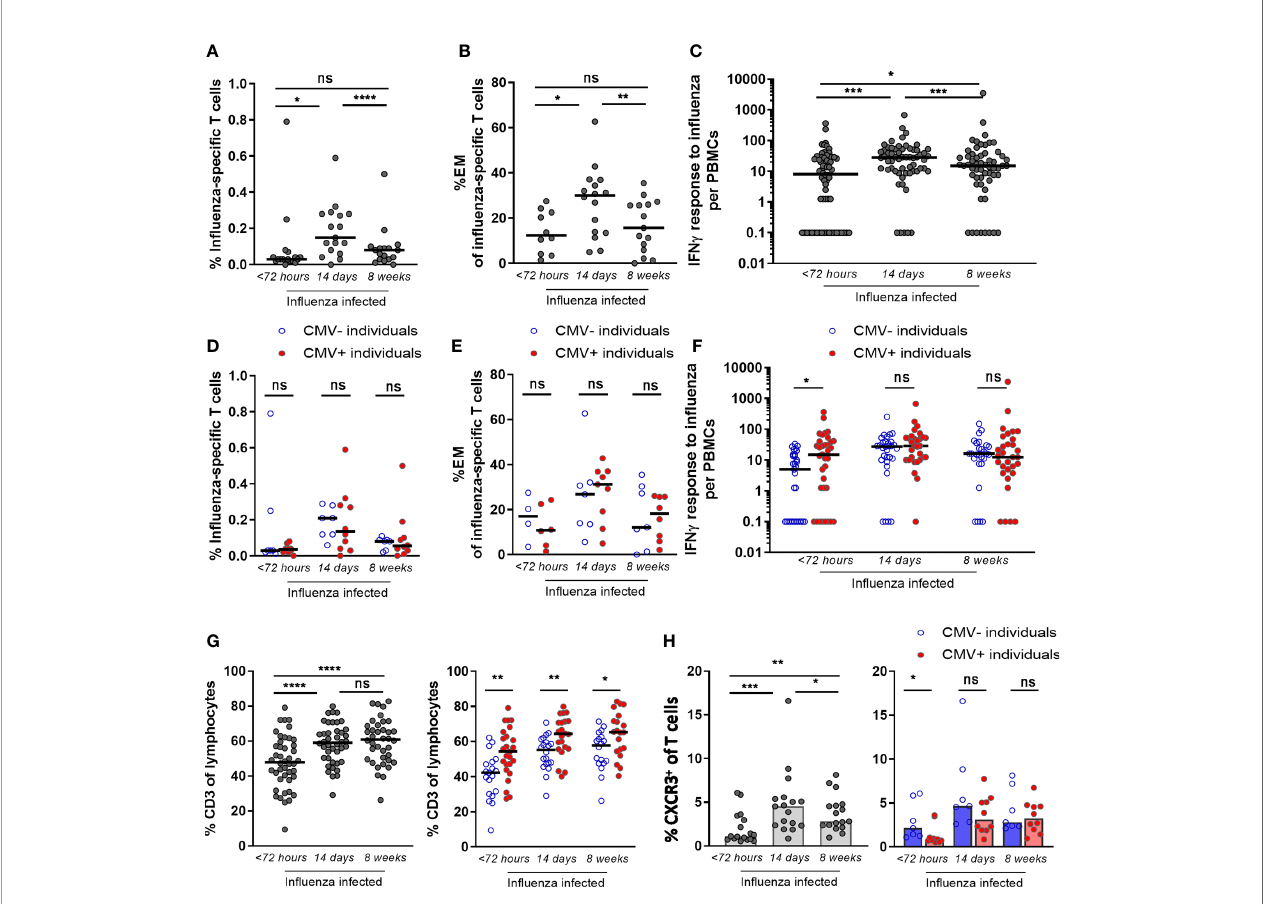
FIGURE 2 | IAV-speci fi c CD8 + T-cell response after infection shows no impairment by CMV seropositivity, but enhancement of the early IAV-speci fi c CD8 + T-cell response. (A) Percentage of IAV-speci fi c CD8 + T cells upon in fl uenza infection. Dextramer for matrix protein-1 GILG-epitope was used (B) The percentage effector memory (EM) cells of IAV-speci fi c CD8 + T cells upon in fl uenza infection. All HLA-A2-positive in fl uenza-infected individuals (n =36) were stained for dextramers; IAV- speci fi c T cells were detected at least at one time point in 17 individuals. (C) IAV-speci fi c IFN g T-cell response upon in fl uenza infection. (D) Percentage of IAV-speci fi c T cells upon in fl uenza infection for CMV - and CMV + individuals. (E) The percentage effector memory (EM) cells of IAV-speci fi c T cells upon in fl uenza virus infection for CMV + and CMV - individuals. (F) IAV-speci fi c IFN g T-cell response upon in fl uenza infection for CMV - and CMV + individuals. (G) Frequencies of CD3 + T cells in the blood of IAV-infected individuals at < 72 hours, 2 weeks and 8 weeks after infection (left panel) and in CMV - and CMV + individuals (right panel). (H) Percentage of CXCR3 + within total CD8 + T cells upon infection (left panel) and in CMV - and CMV + individuals (right panel). Wilcoxon test was used to compare T-cell responses of individuals in time and Mann-Whitney U test was used to compare CMV - and CMV + individuals. Correlation between CMV-speci fi c immune responses and IFN g response to in fl uenza virus was tested by Spearman correlation. T-cell IFN g responses are presented per 1 x 10 6 PBMCs. *P < 0.05, **P < 0.01, ***P < 0.001, ****P < 0.0001. ns, non signi fi